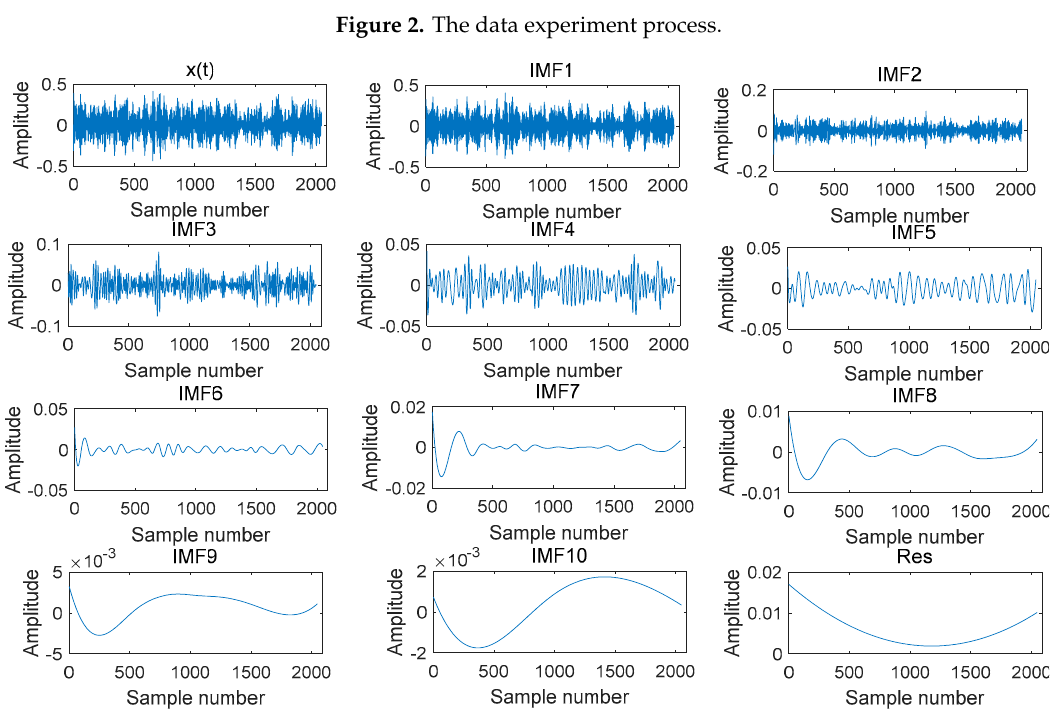
Figure 3. The intrinsic mode function( IMF) components of the vibration signals.